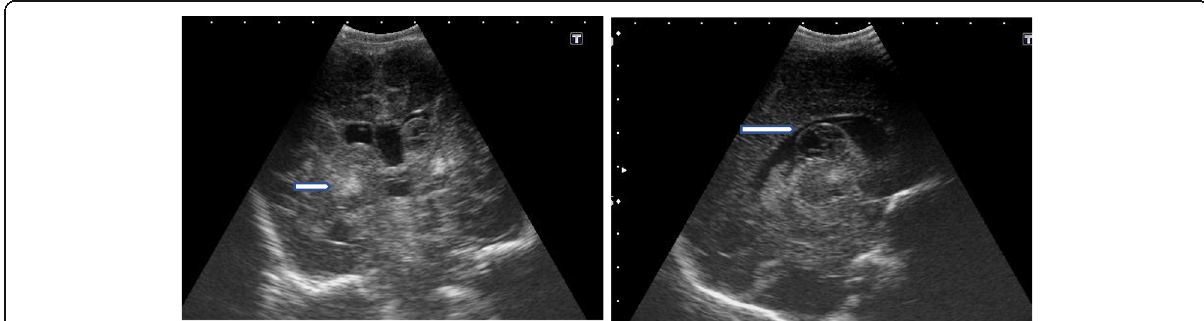
Fig. 9 Coronal and sagittal US of a neonate full term. CS, cyanoses, Apgar scoring 2 and 4 at 1 and 5 min, anteparum hge, mechanical ventilator, and meconium aspiration syndrome. Sarnat stage III. Cranial US revealed aging subependymal hge (arrow), bilateral basal ganglia focal ecchognic areas (arrow head), and severe